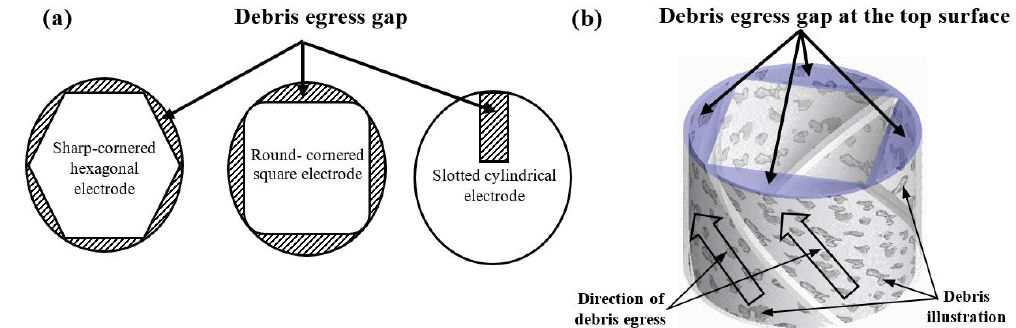
Figure 3. ( a ) The cross-sectional area and the debris egress gap for three different electrode geometries: from the left to the right, the sharp-cornered hexagonal electrode, the round-cornered square electrode and the slotted cylindrical electrode; ( b ) a 3-D representation of the debris egress for the sharp-cornered square electrode.